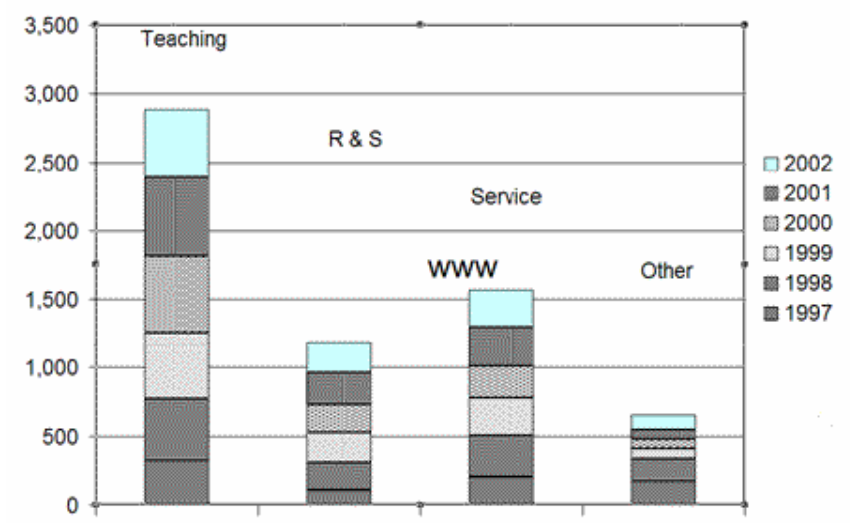
Figure 2. Mean hours worked per semester per academic in the broad categories of responsibility: 1) teaching (undergraduate and postgraduate coursework); 2) research and scholarship; 3) service to the institution and the community; 4) other (professional development, consultancy/outreach). Data from Faculty of Rural Management, University of Sydney, 1997–